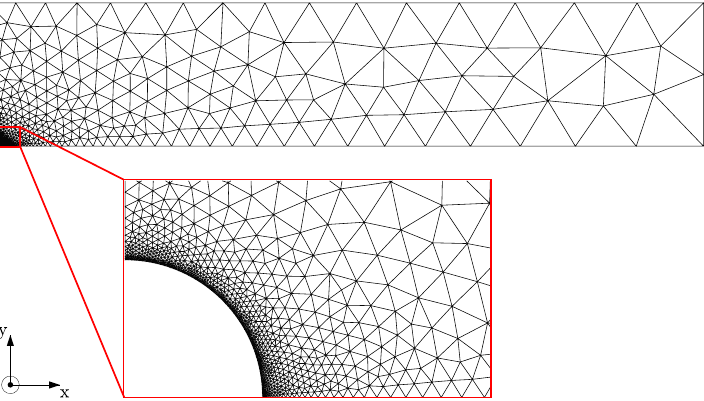
Figure 4. Mesh used in the numerical simulations of the fiber-pulling problem. As mentioned in the description of the methods, a 3D problem was solved on a 2D mesh, which heavily reduced the number of elements and, hence, allowed for considerable mesh refinement close to the fiber surface, as shown in the